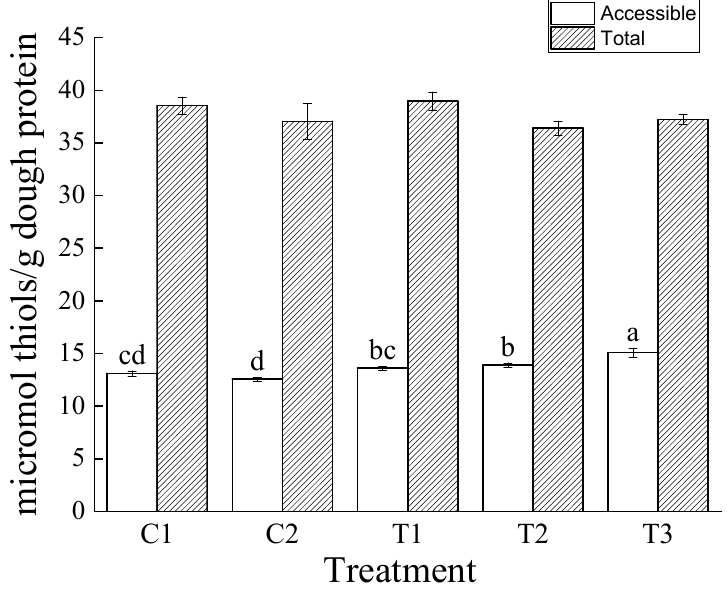
Figure 4. Accessible (white columns) and total (striped columns) thiols in dough samples. For sample identifiers, see Table 1. Error bars represent standard deviations ( n = 3) and different letters denote significant differences among accessible thiol samples. No significant differences were present among total thiols.